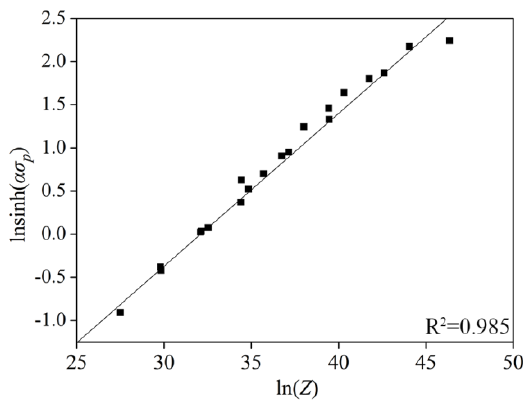
Figure 6. Schematic of ln [ sin h ( ασ p )] versus ln Z .